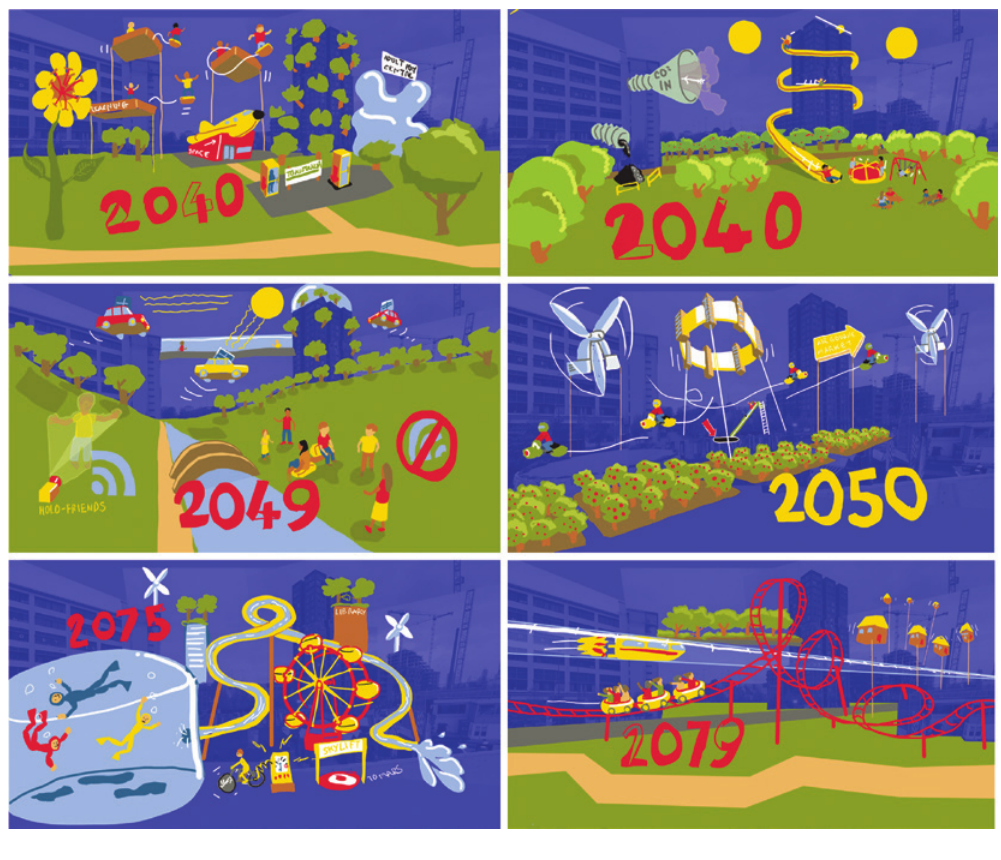
figure 5: example live aR illustrations by sam steer, from Billennium at Dutch Design Week 2019, eindhoven, the